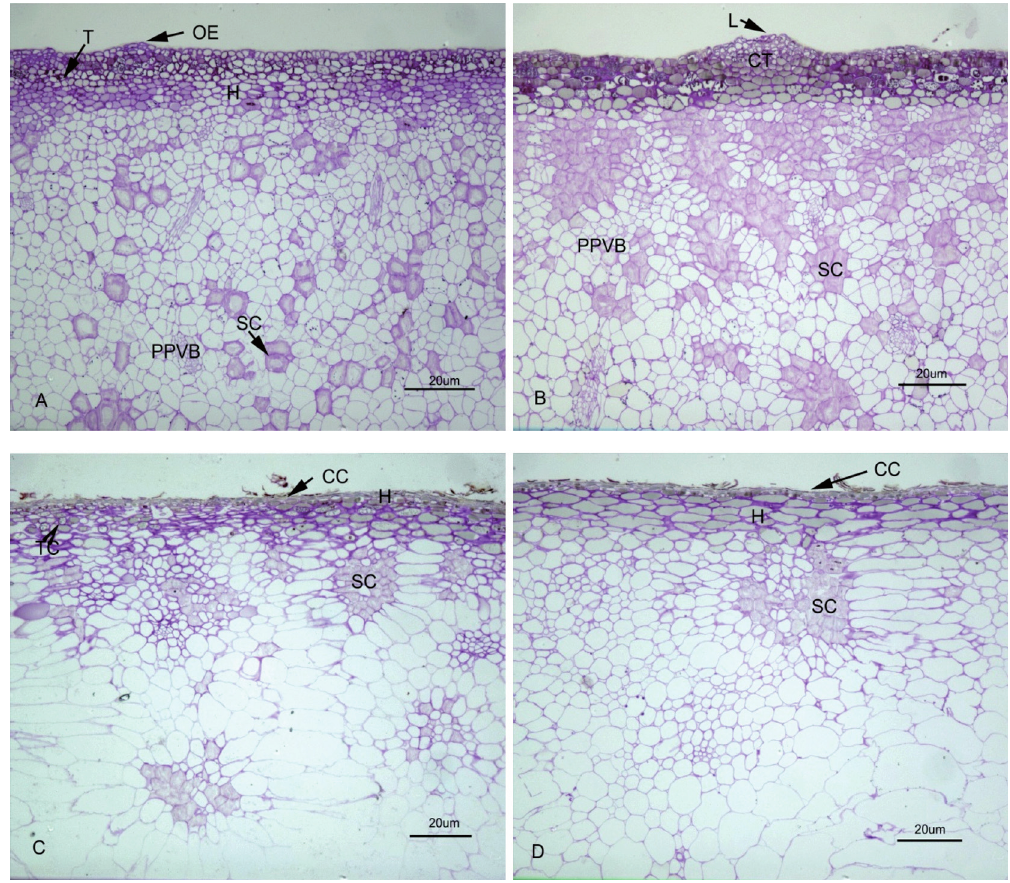
Fig. 3: Changes of flesh and epidermal tissue observed by the light microscope (100×) on 30 (A), 60 (B), 90 (C) and 150 DAFB (D) in ‘Niitaka’ pear. H: hypodermis, CC: cork cell, NTC: non-tannin cell, SC: stone cell, and TC: tannin cell.